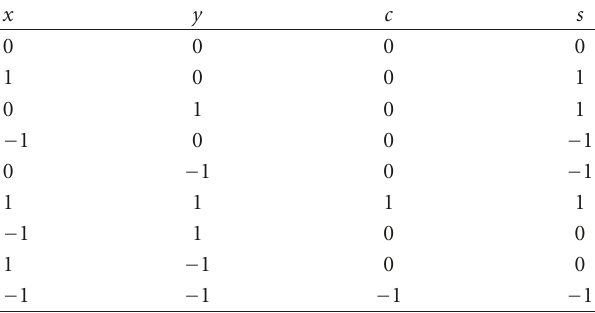
Table 1: Truth-table of the proposed THA.